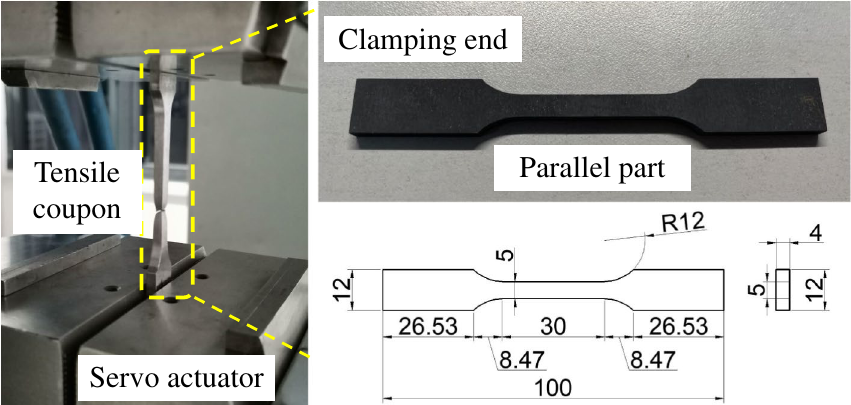
Fig. 6 Geometry of the Fe‑SMA tensile‑test coupon and test set‑up